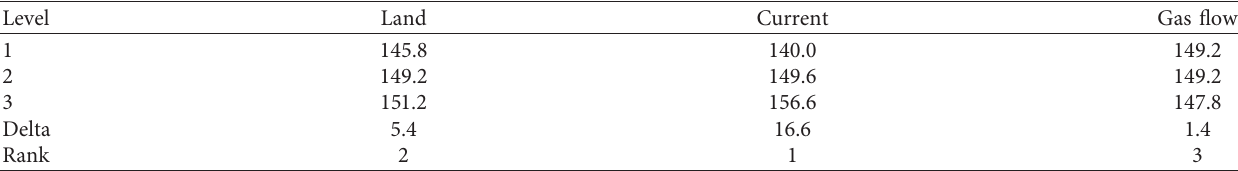
Table 17: Taguchi analysis (hardness: larger is better)—response table for means.